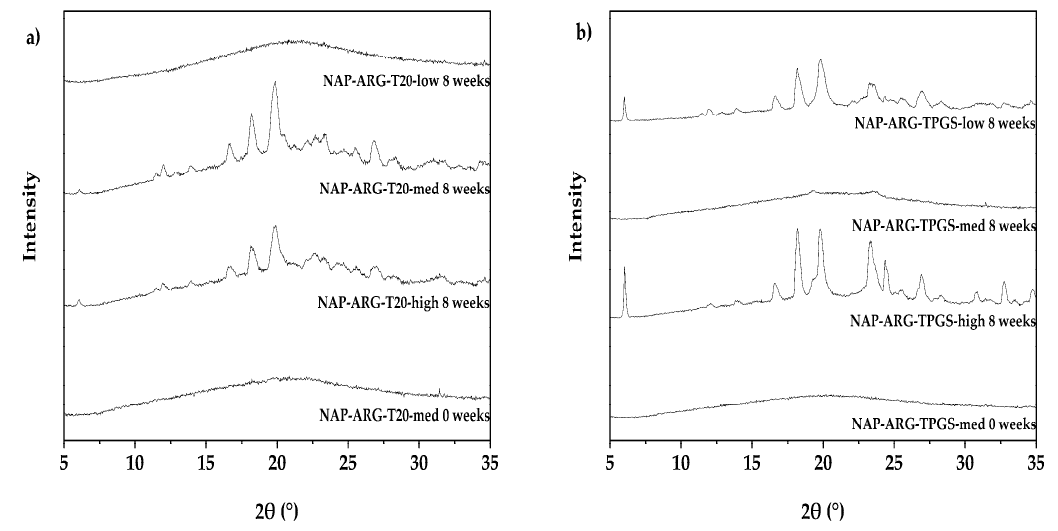
Figure 4. Physical stability by XRPD for different naproxen-arginine (NAP-ARG) salts: NAP-ARG-Tween 20 ( a ) showing improved stability with a low concentration of surfactant after 8 weeks, NAP-ARG-TPGS ( b ) showing an optimum for surfactant at the medium concentration.